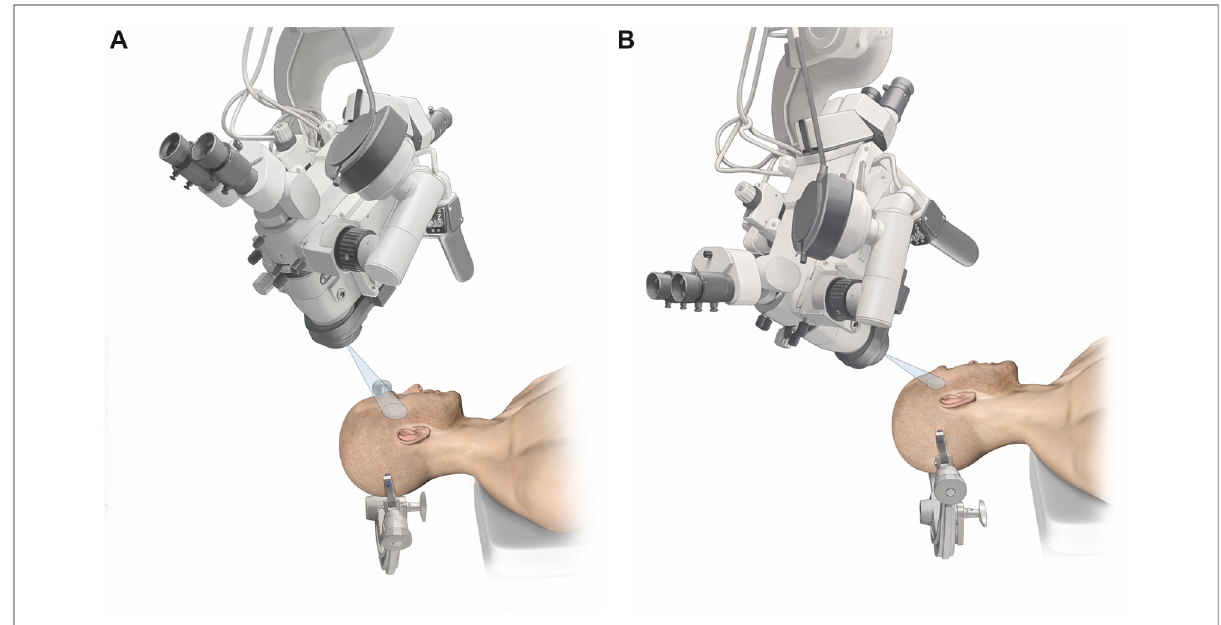
FIGURE 4 Operative microscope orientation and head rotation for the ( A ) MPT and the ( B ) SKA.